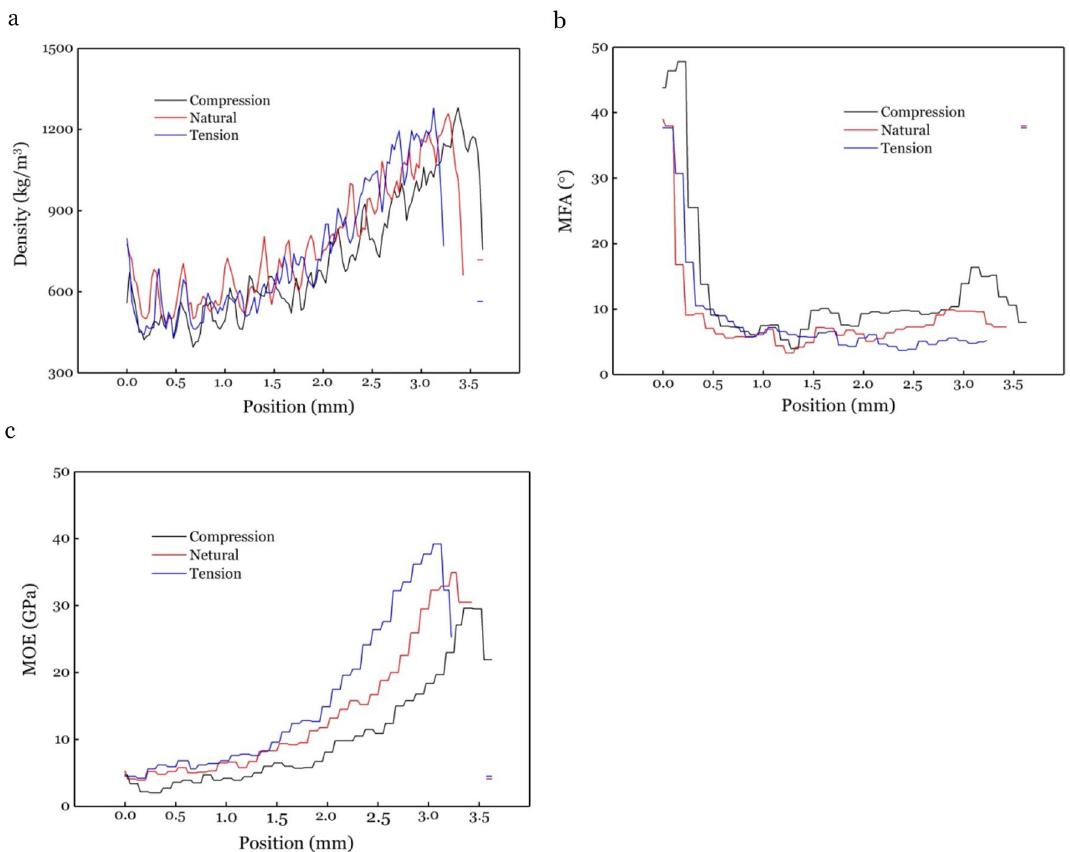
Figure 5. Density ( a ), MFA ( b ) and MOE ( c ) distribution along radial direction from bamboo yellow to bamboo green of different bamboo cross-section from YL to GL can be found in all three samples, with the density distribution of the C sample lower than the N sample. Arithmetic mean density values for C, N and T samples are calculated as 720.38 kg/m 3 , 775.97 kg/m 3 and 742.75 kg/m 3 separately, indicating that the mean density of C and T samples decreased compared with N sam- ple in bending bamboo. The mean density of compression and tension wood also differed from tension wood, which showed positive correlation between density and tension wood fibres percentage 22,23 . Density generally correlate strongly with wood shrinkage 24 . The decrease of density in compression and tension part was helpful in improving the dimensional stability of bent bamboo. Strain would come with increasing stress when material experience any kind of external force. In some cases, stress is not large enough to produce obvious deformation, but it is difficult to precisely measure stress and strain inside wood, bamboo, or other materials. In general, when there is large stress, strain is visible and can be measured more accurately. Bending is a kind of obvious strain with the material experiencing bending load ultimately resulting in bending section deformation 25,26 . Tube section would change from circular to elliptical after bending 27 , which is a function of different degrees and forms of pore deformation. Following pore deforma- tion, section density redistribute (Fig. 5a), which result in stress redistribution on the bending section of inner, middle and outer side 28 . MFA distribution along radial direction. MFA is defined as an inclination of microfibrils from the lon- gitudinal axis, which play an important role in determining the final mechanical properties of bamboo 29 and wood 30 . There are a lot of factors which may affect MFA in wood or bamboo, such as ages 29,31 , species 32 , and locations in cross-Sect. 31 . Although previous research has been carried out on MFA distribution along radial direction by picking some points on the cross section 31 , little research has been done to examine the continuous distribution of MFA along radial direction. MFA distributions along radial direction at a 0.1 mm resolution for sample C, N and T are shown in Fig. 5b. The MFA were highest (38° ~ 48°) in about 0.2 ~ 0.5 mm near YL, followed by sharp decrease (10° ~ 4°) in distance of 0.5 ~ 1.8 mm from YL. A small increase was saw in the last 1 mm for C and N, except T. Arithmetic mean MFA values for C, N and T are calculated as 12.5°, 8.3° and 8.3° in the whole bamboo wall thickness. Although MFA showed nearly same arithmetic mean value in samples N and T, the value of the outer half bamboo wall near the green part experienced the greatest bearing strength 32 . The C, N and T near the GL were calculated as 11.0°, 7.5° and 5.0° with larger distance between the three MFA distribution.